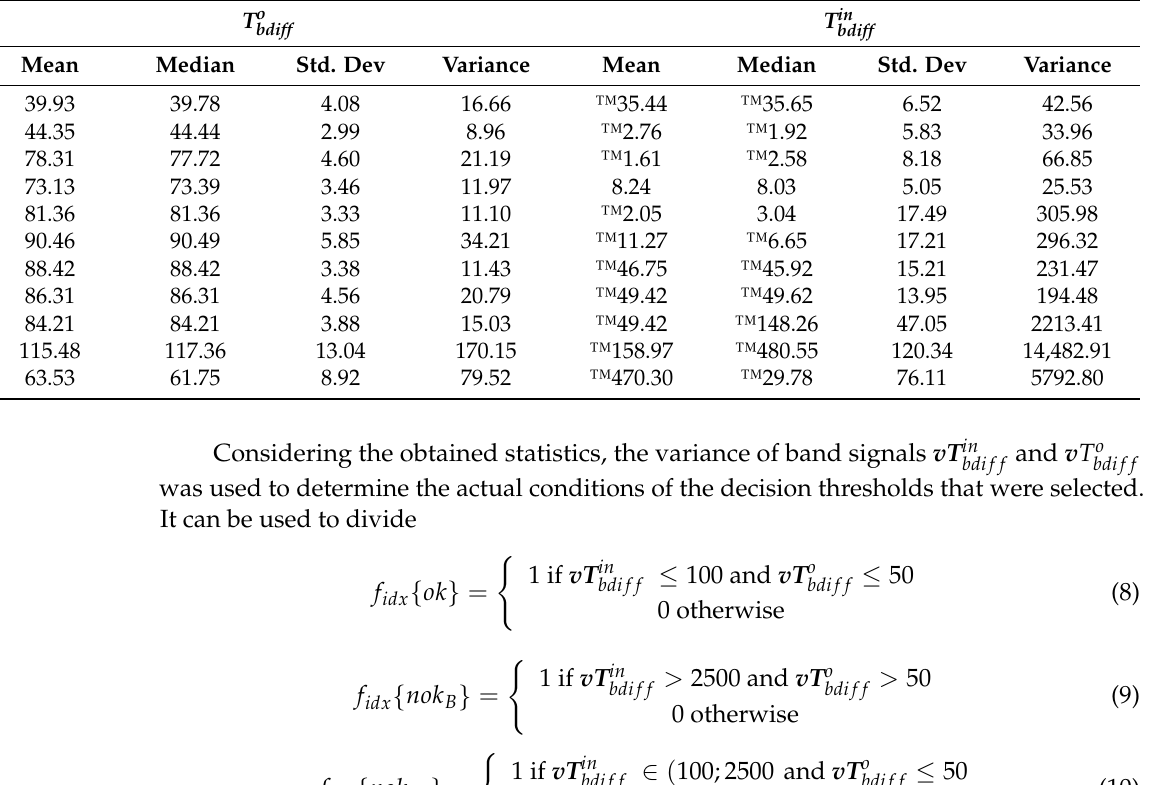
joint bands. and outer T o bdif f bdif f T in